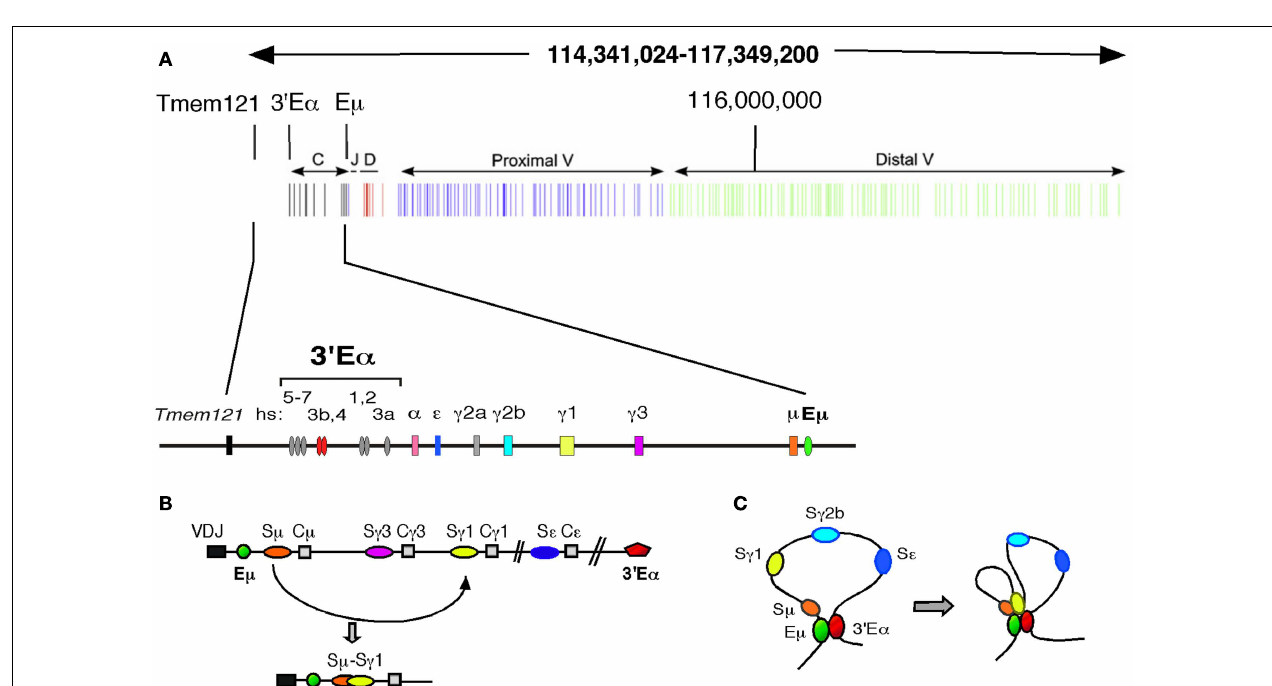
promoters, located upstream of I exon-S-C H regions, focus CSR to specific S regions by differential transcription activation (50, 67). Prior to CSR and upon GLT expression, S regions become accessible to AID attack. AID initiates a series of events culminating in formation of S region specific double strand breaks (DSBs) at the donor S µ and a downstream acceptor S region (50). DNA DSBs in transcribed S regions are essential for CSR. Here, S µ and S γ 1 acquire AID induced DSBs and engage in CSR to form recombinant S µ /S γ 1 regions. (C) In mature B cells E µ :3 (cid:48) E α interactions create a long range chromatin loop encompassing the C H domain of the Igh locus (left). Upon B cell activation with LPS + IL4, long range chromatin interactions directed by the GLT promoters and Igh enhancers creates spatial proximity between S µ and the downstream S γ 1 region locus (46).This spatial proximity facilitates recombination between the broken S regions and creates a matrix of chromatin contacts, which stabilize the locus during the recombination